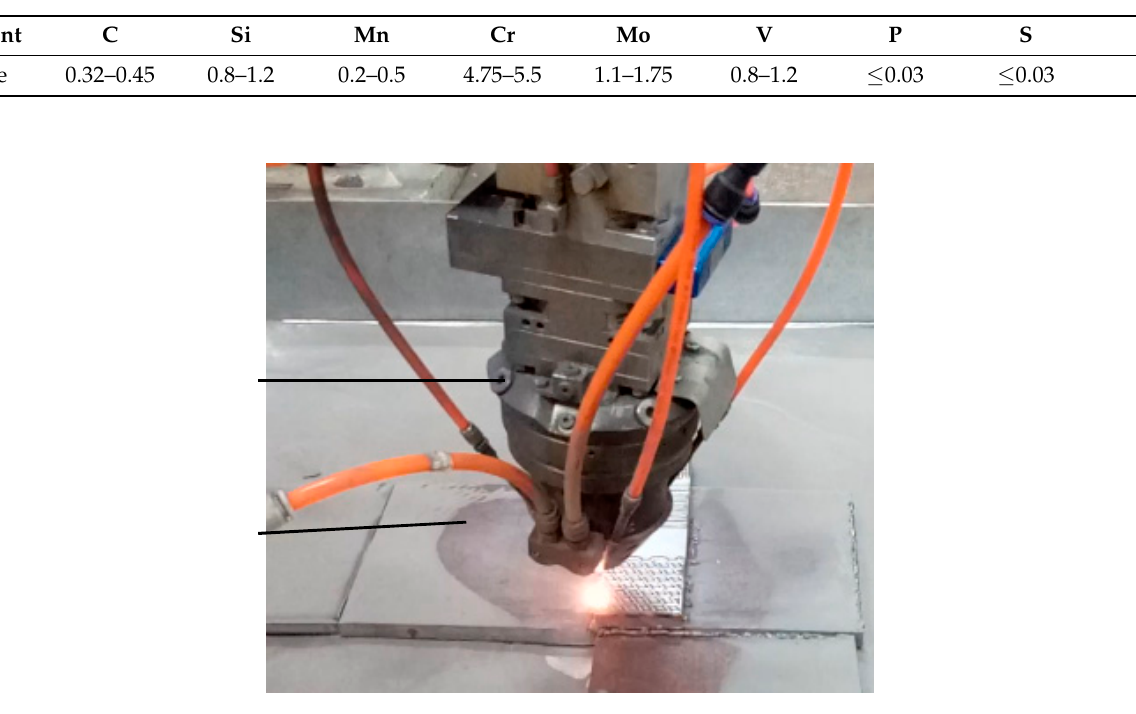
Table 2. Main components of substrate (%).